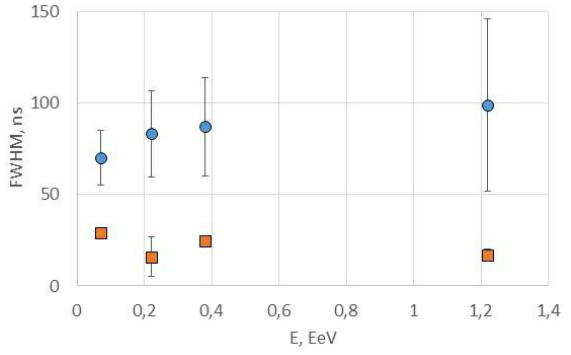
Figure 4. Axis distance distribution of the shower fraction de- tected with telescope